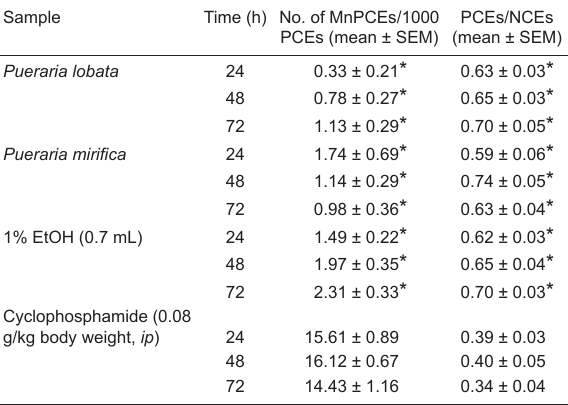
Table 4. Micronucleus assay in rat bone marrow at 24, 48, or 72 h after oral administration of Pueraria mirifica or P. lobata extracts at the dose of 16 g/kg body weight.